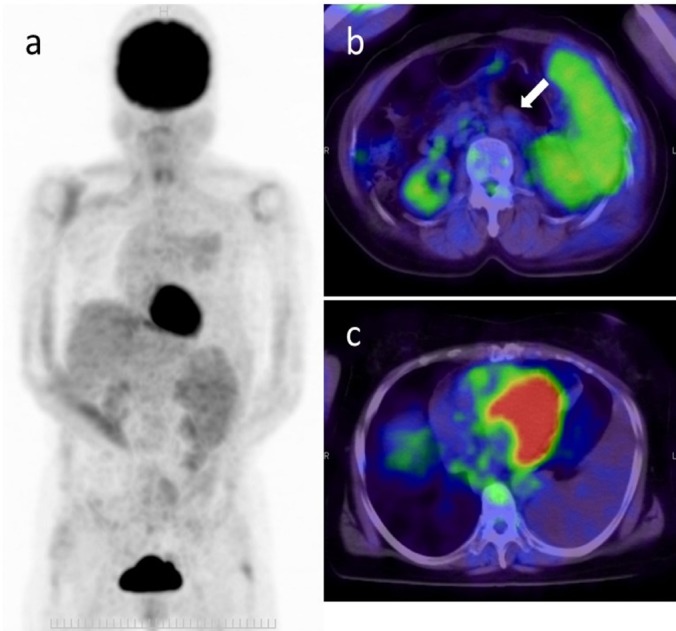
A 59-year-old woman with lymphoma;(a) Maximum intensity projection image and (b, c) fused FDG-PET/CT images are shown. The patient was referred to our hospital for further evaluation and treatment of left pleural effusion, splenomegaly, and paraaortic lymphadenopathy. The level of sIL-2R was within normal limit (378 U/ml). FDG-PET/CT showed splenomegaly with diffusely increased FDG uptake (SUVmax=3.9) (b) and left pleural effusion (c). Although paraaortic lymphadenopathy was also observed (b; white arrow), the FDG uptake was mild (SUVmax=1.8). The evaluators commented that this case was compatible with low-grade lymphoma. Confirmed diagnosis obtained by splenectomy was peripheral T cell lymphoma